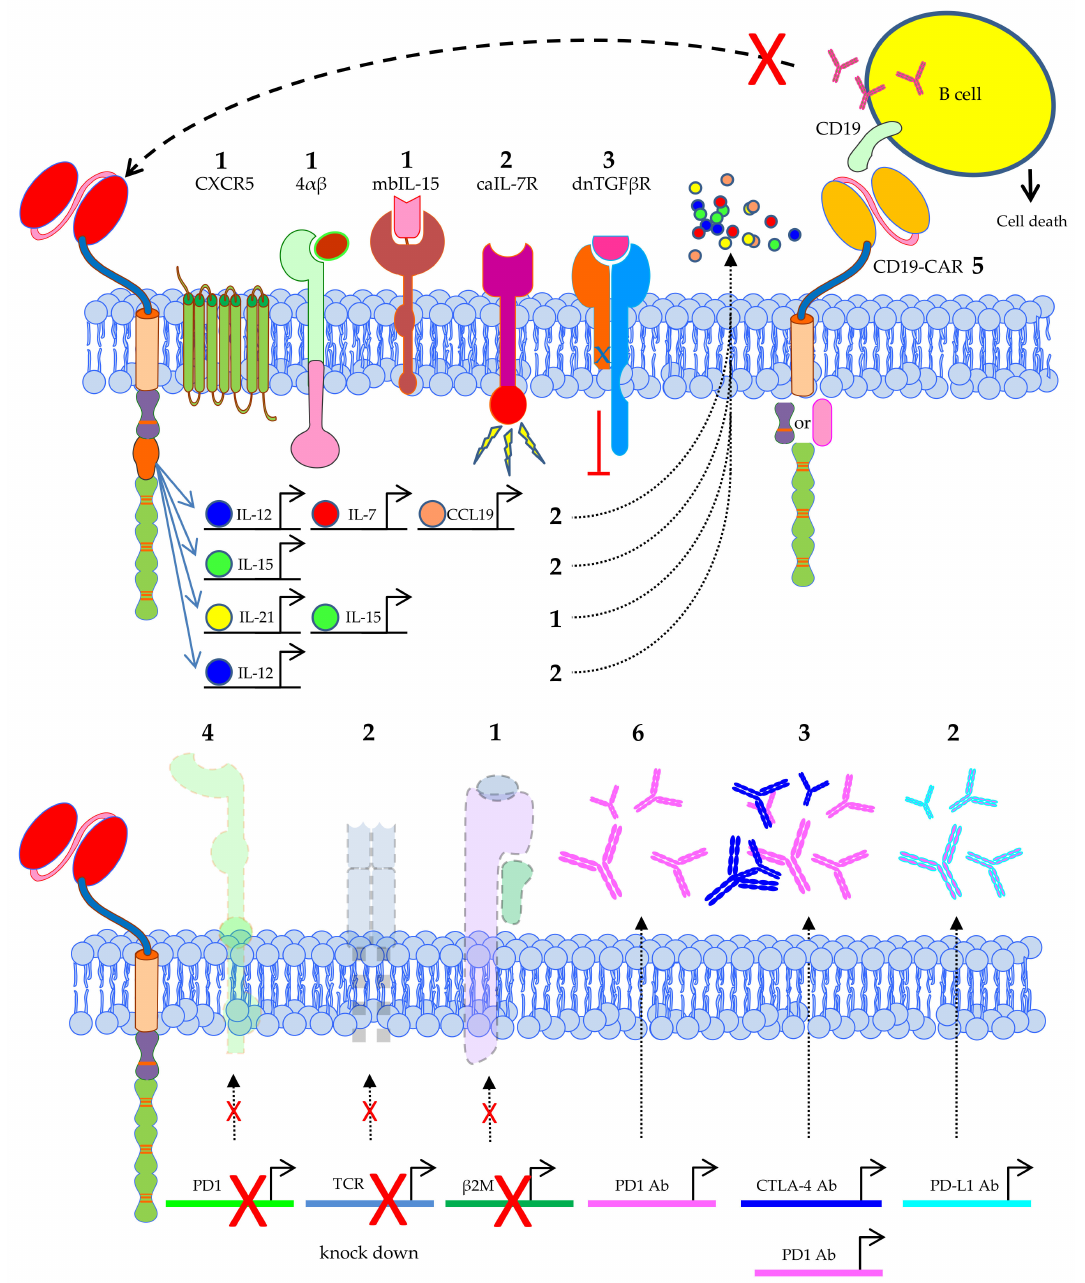
Figure 7. Schematic overview of the extra features introduced into CAR-T cells used in clinical trials treating solid tumors. The number of clinical trials using a specific feature is indicated. Data was extracted from clinicaltrials.gov. 4 αβ = chimeric cytokine receptor containing the IL-4R α ectodomain coupled to the IL-2R β endodomain, mbIL-15 = membrane-bound IL-15, caIL-7R = constitutively active IL-7 receptor, dnTGF β R = dominant negative TGF β receptor. The Motifolio Scientific Illustration Toolkit was used for the generation of parts of this